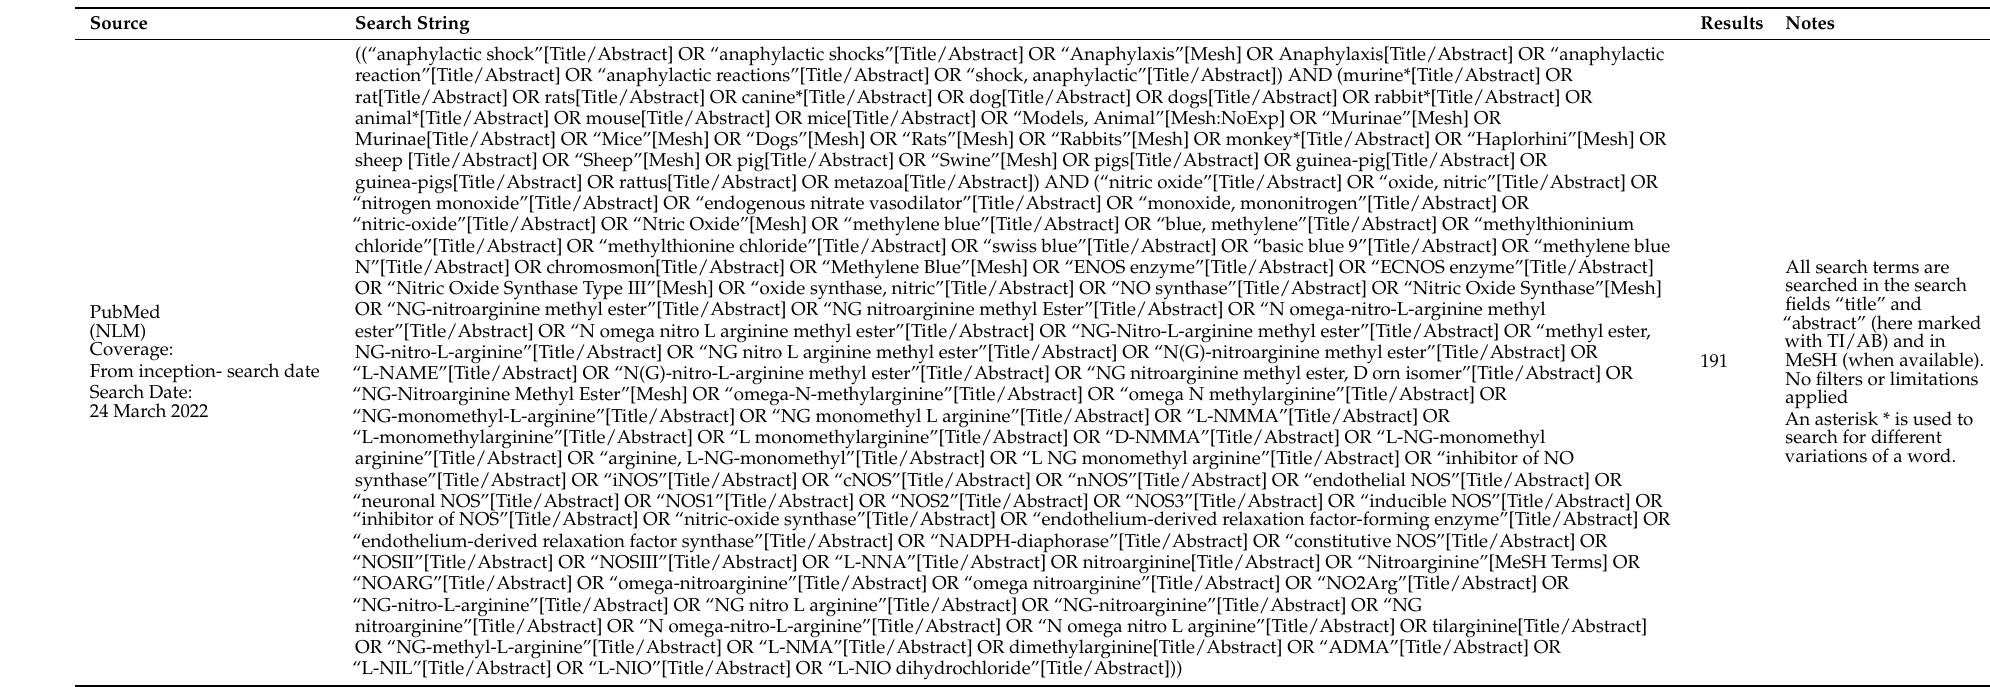
Table A1. Search string and results of database search. Nitric oxide synthase (NOS), title and abstract (TI/AB), endothelial constitutive nitric oxide